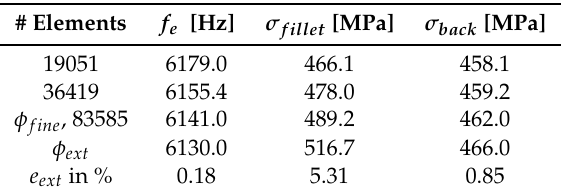
Table 2. Mesh study on CSM mesh.